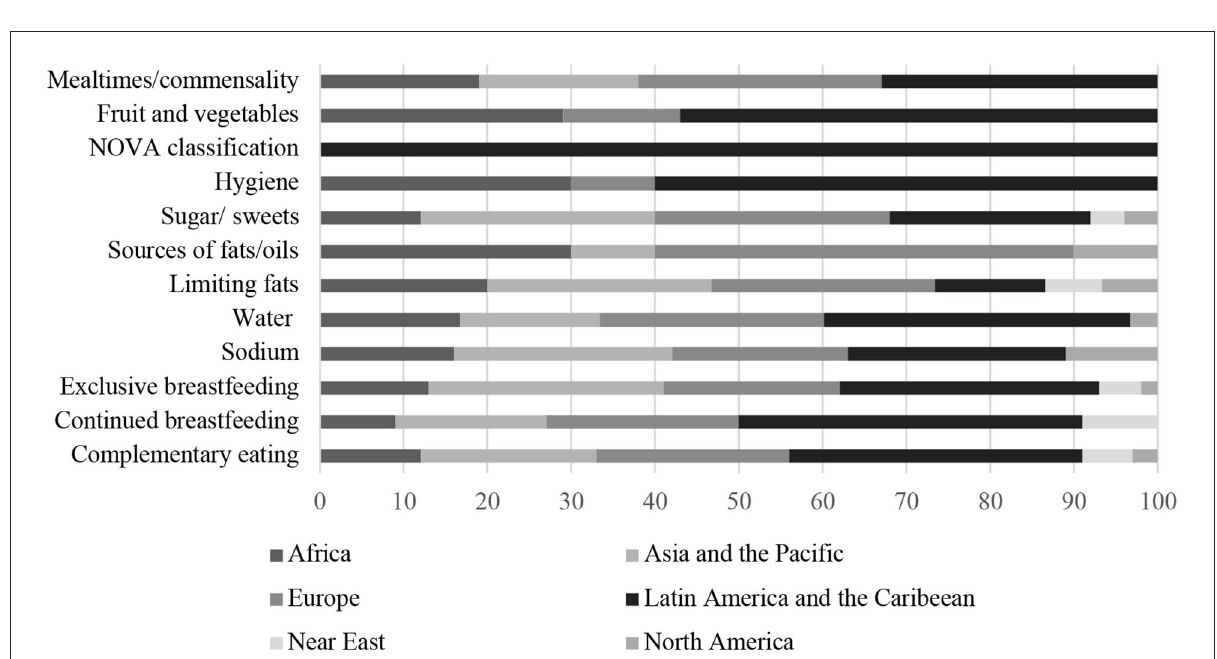
FIGURE4 Percentage distribution of FGDBs with specific nutritional recommendations according to world